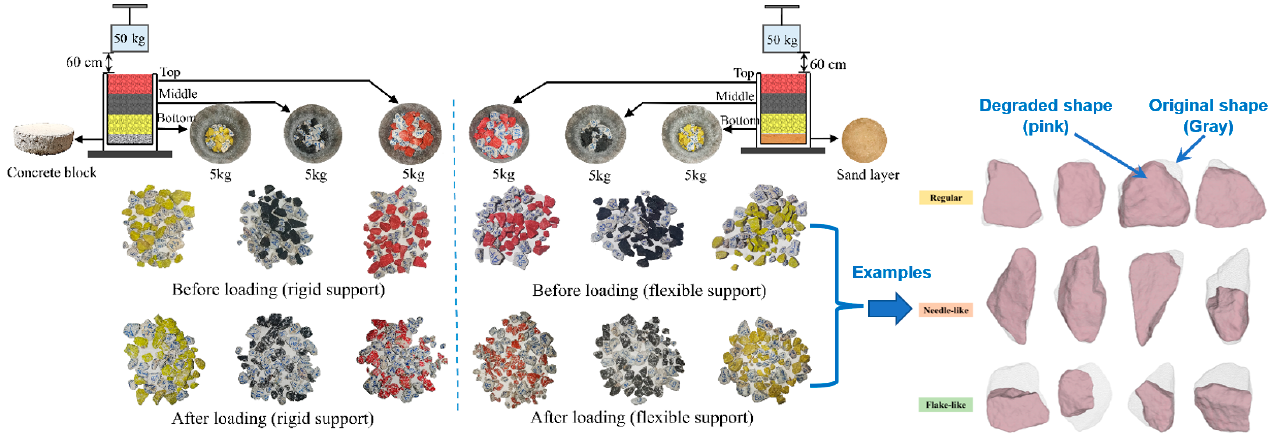
Figure 12. Photos of particle-size-degradation trends of regularly shaped multiple-size ballasts upon the completion of every 10 impact-load applications under the combination of a rigid concrete block support and an 80 cm drop height.